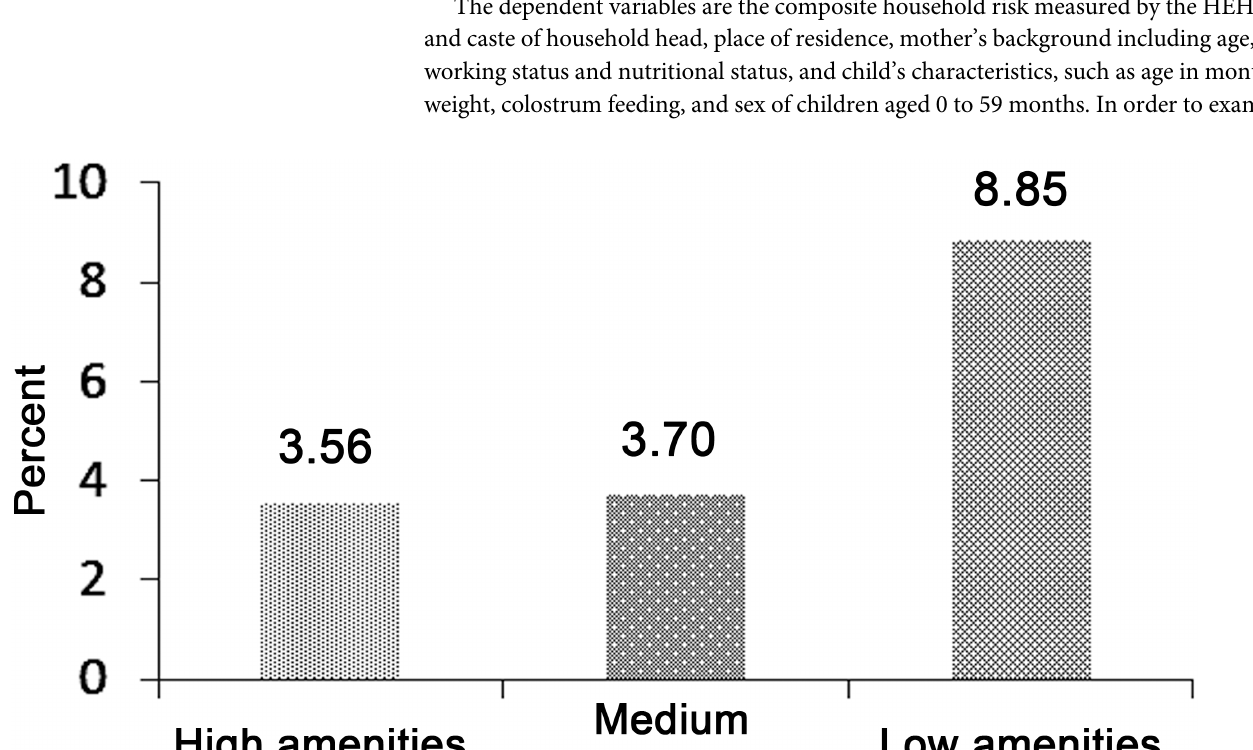
PLOS ONE | DOI:10.1371/journal.pone.0130567 June 29,